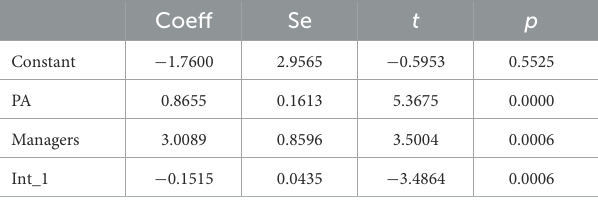
TABLE 11 Deep Acting and Personal Accomplishment, with feedback from the managers as the moderator. Coeff Se t p Constant